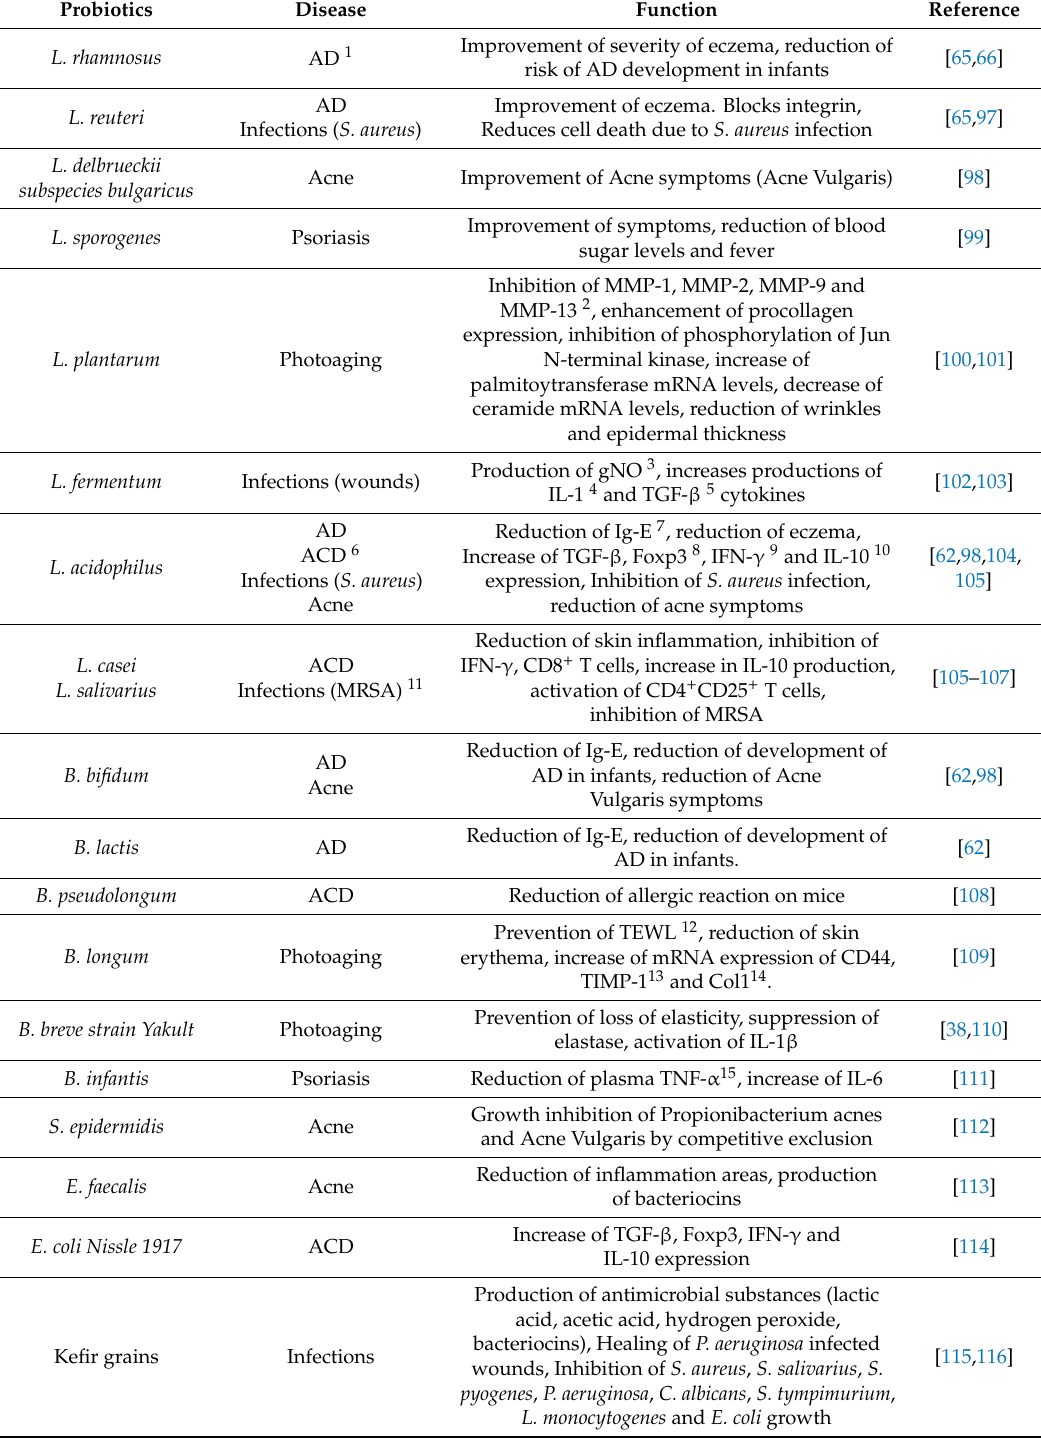
Table 1. Probiotics and their e ff ect on skin